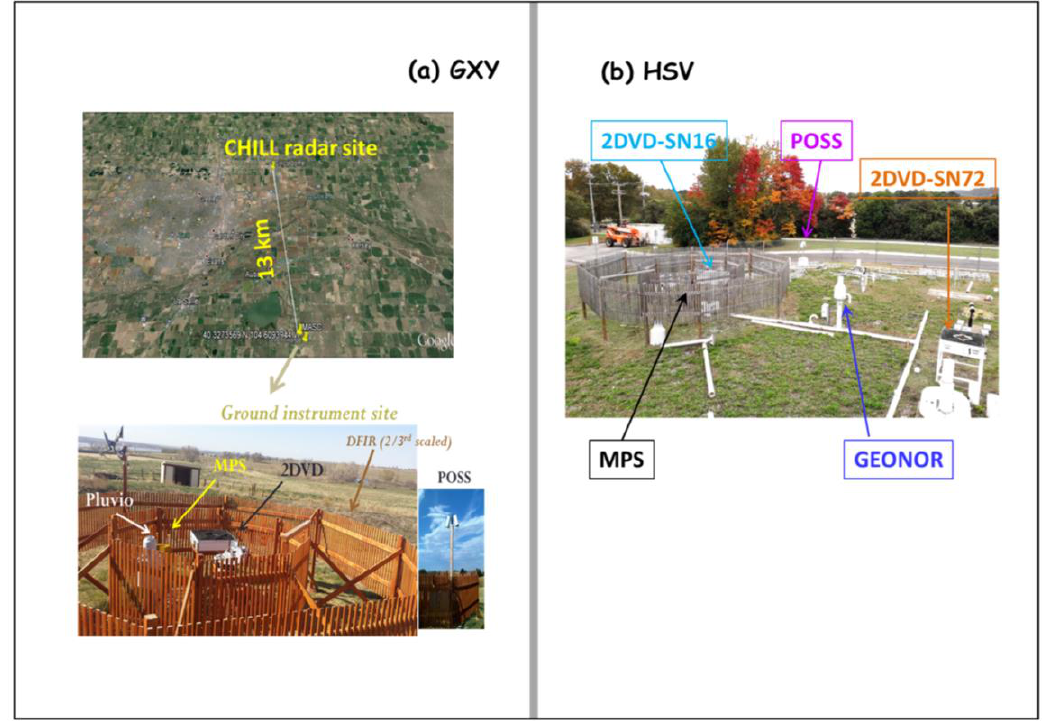
Figure 1. ( a ) Ground instrumentation at Greeley (GXY), 13 km away from the CSU-CHILL radar site; ( b ) ground instrumentation at the Huntsville (HSV) site.